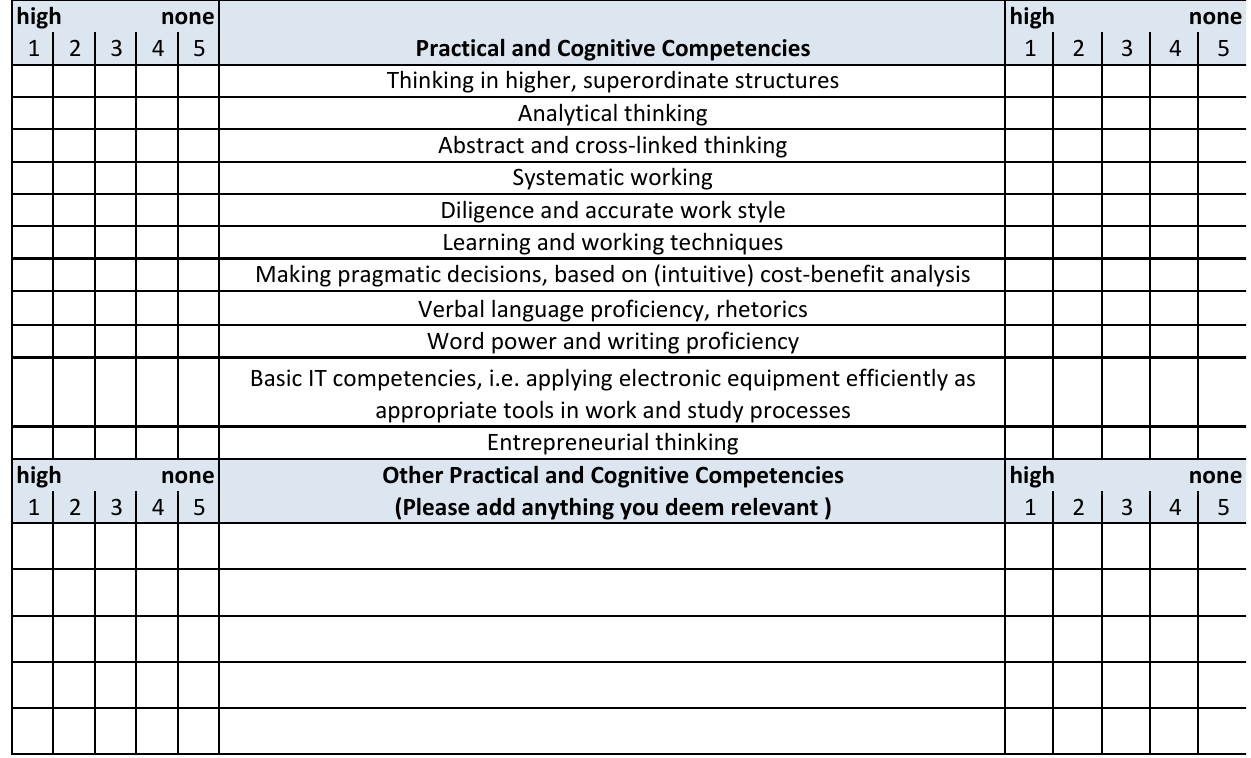
Figure 6. First page of our questionnaire for lecturers on the competencies of incoming first year students (translated from the German